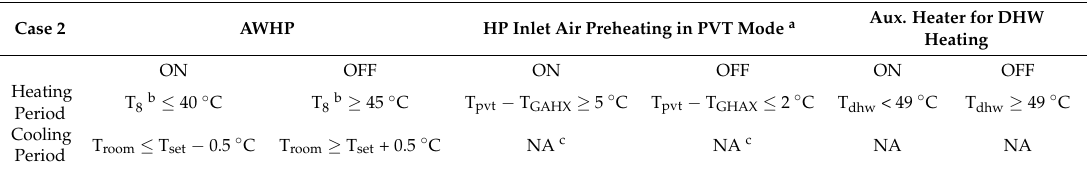
Table 4. Control strategies for trigeneration system with integration of air-to-water heat pump, photovoltaic thermal panels and ground-to-air heat exchanger (Case